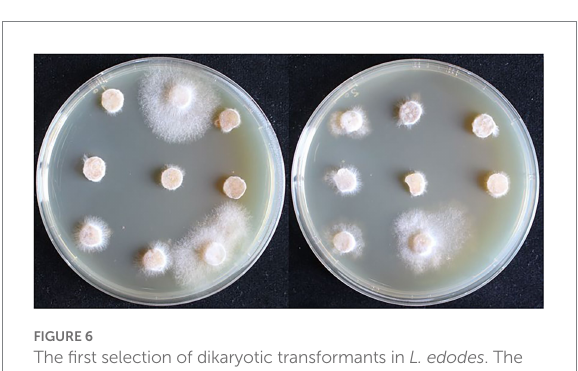
FIGURE 6 The first selection of dikaryotic transformants in L. edodes . The mycelia can germinate and extend on the resistant medium are